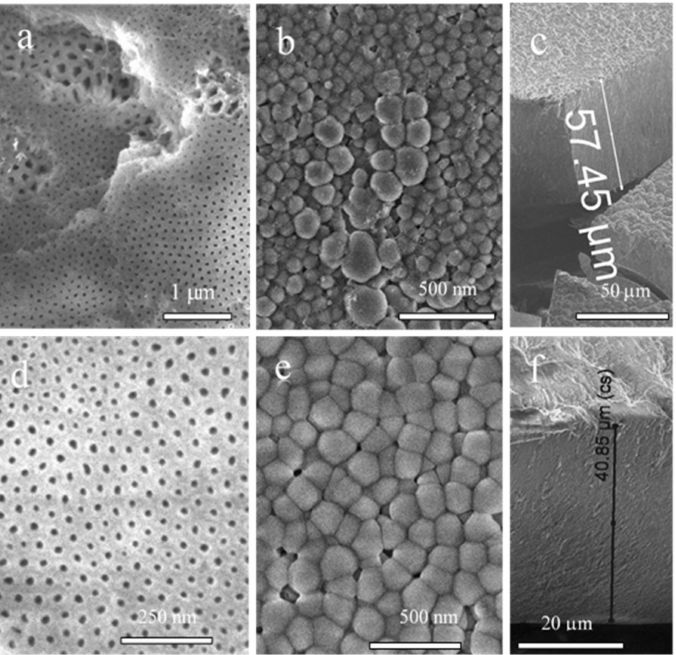
Figure 3. Top-side ( a , d ), back-side ( b , e ), and cross-sectional ( c , f ) SEM images of anodic film formed from Al anodization in a solution containing 0.8 mol · L − 1 HCOOH and 0.2 mol · L − 1 NaVO 3 (pH 2.7; 20 ◦ C) at 60 V ( a – c ) and 80 V ( d – f ) for 1